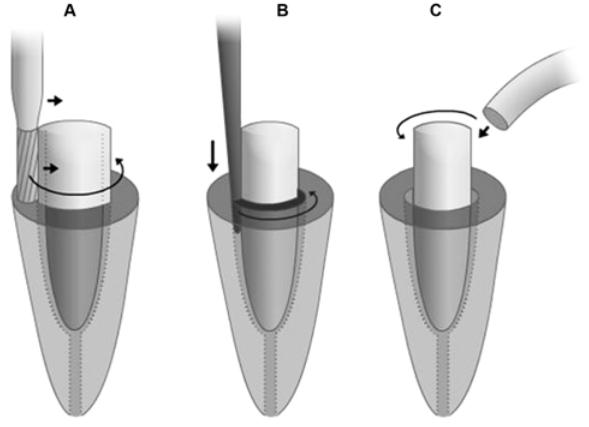
FIGURE 1 - Procedures for intraradicular cast post